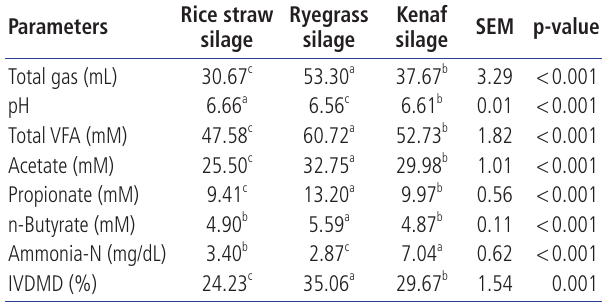
Table 2. Effect of kenaf silage supplementation on in vitro rumen fermentation Parameters